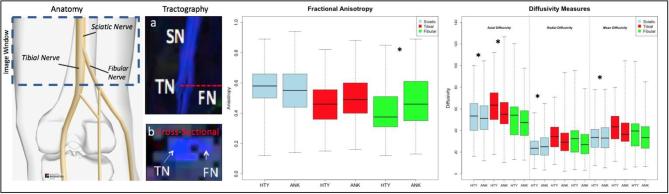
Peripheral nerve measures. (Left) A schematic is outlined showing the recording window and its position within the leg as well as representations of the sciatic, tibial and fibular nerves using schematic and tractography representations. Recordings were taken from both the left and right legs. (Middle) Findings from the diffusion weighted imaging analysis using fractional anisotropy as well as other diffusion measures (Right). * Indicates a significant difference (p < 0.05) in a regression model controlling for the recorded leg (left or right) and the location of injury (left or right ankle). HTY = Healthy; ANK = Ankle Injury.